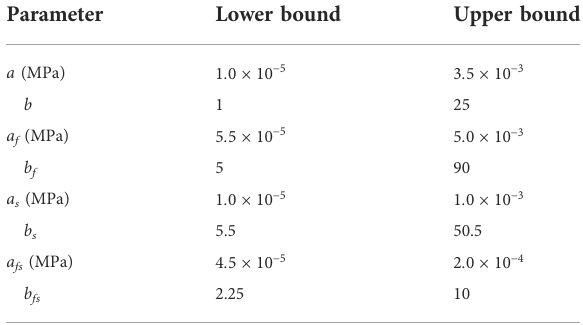
TABLE 2 The passive parameter